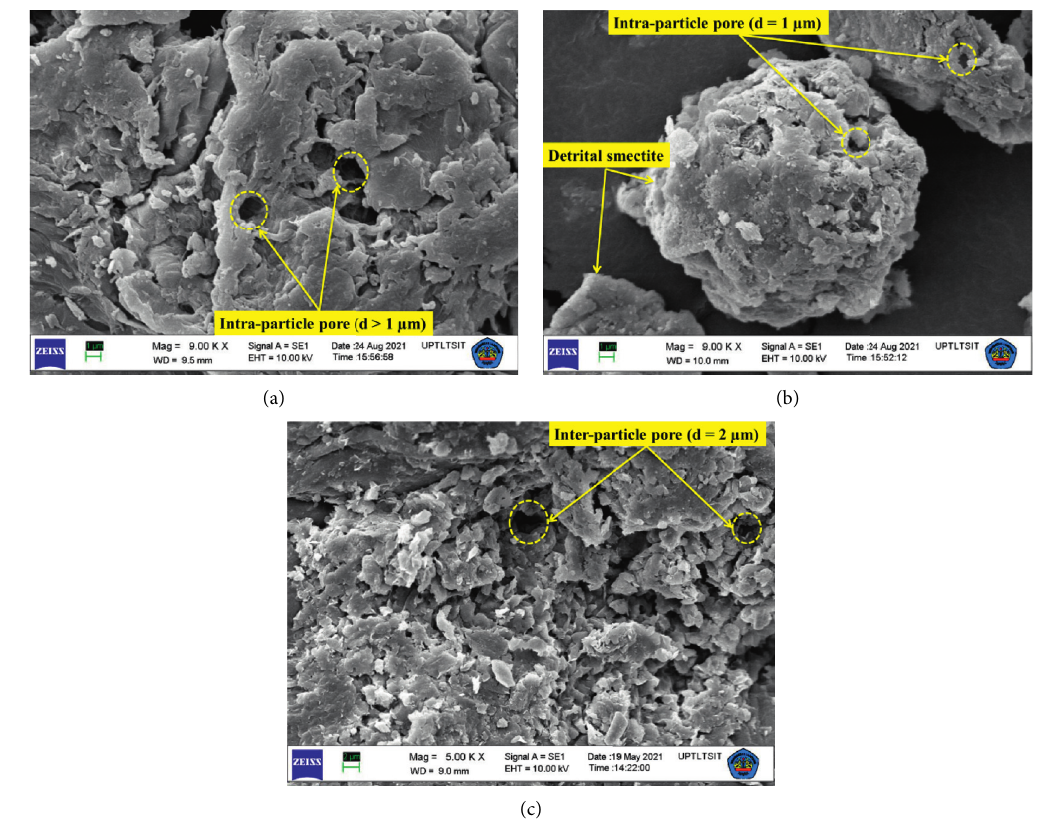
Figure 2: SEM micrographs of (a) chitin, (b) bentonite, and (c) CB hybrid materials.